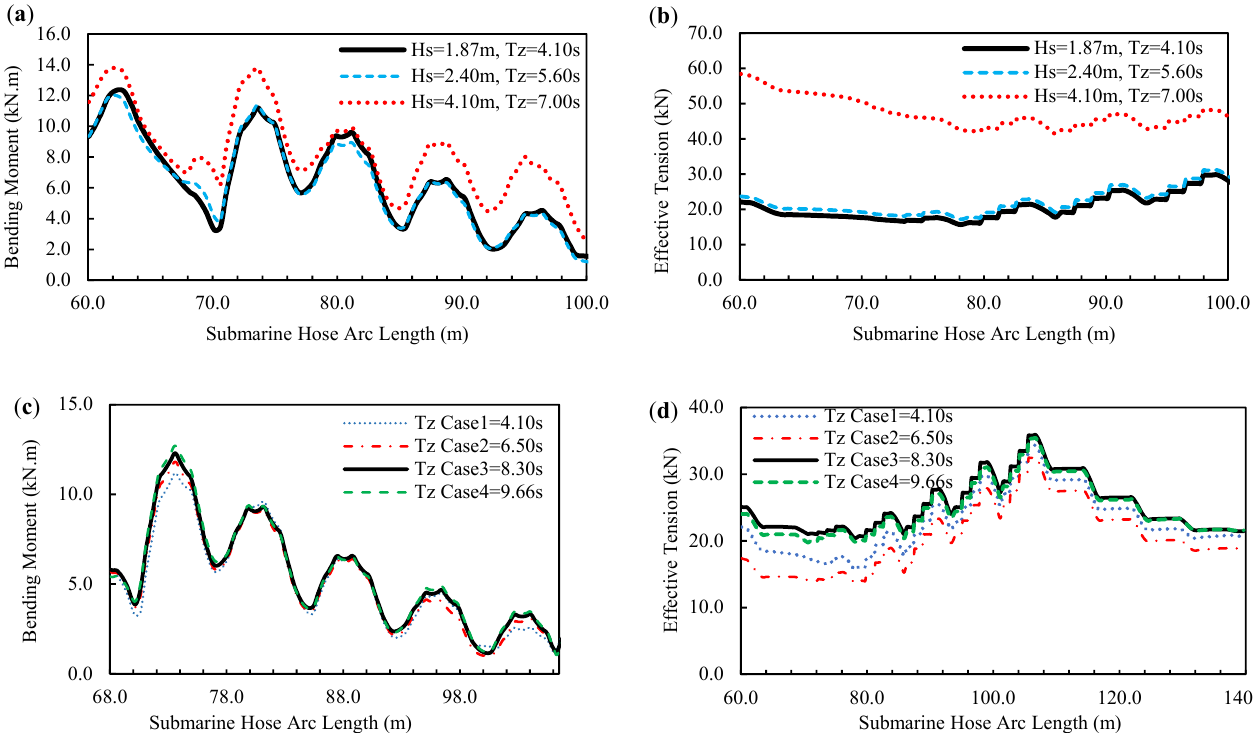
Figure 29. Influence of environmental conditions on submarine hoses. ( a ) Bending Moment for load cases. ( b ) Effective tension for load cases. ( c ) Bending Moment for Tz. ( d ) Effective tension for Tz.